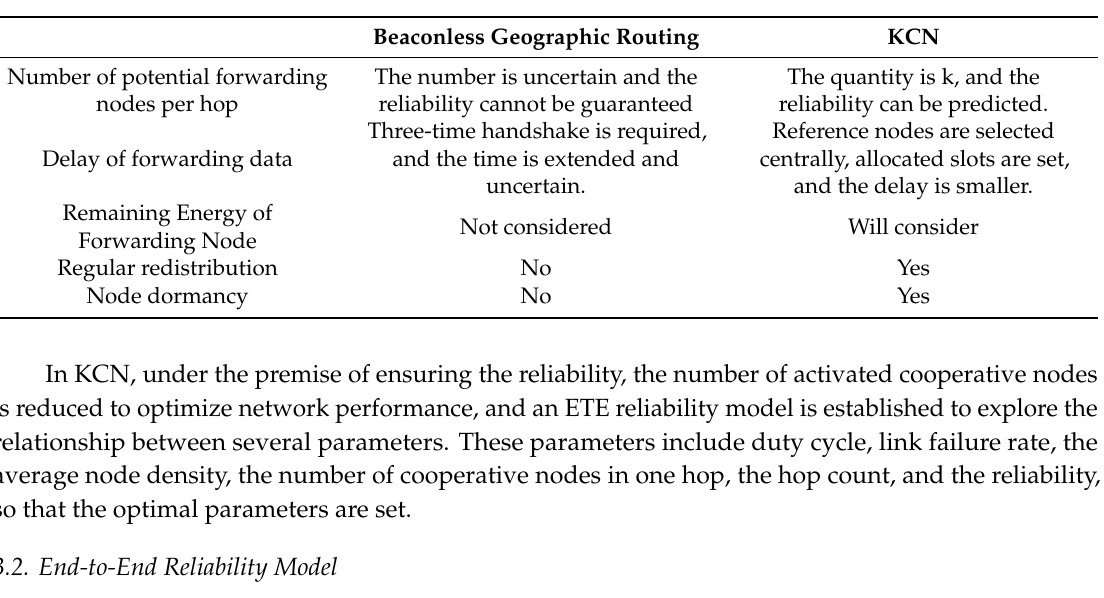
Table 1. Comparison of KCN and beacon-free